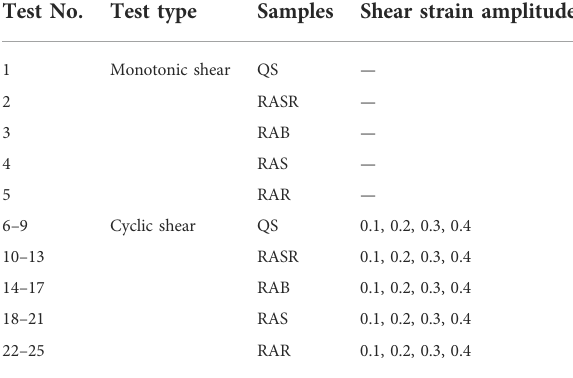
TABLE 3 Design of the monotonic and cyclic simple shear tests. Test